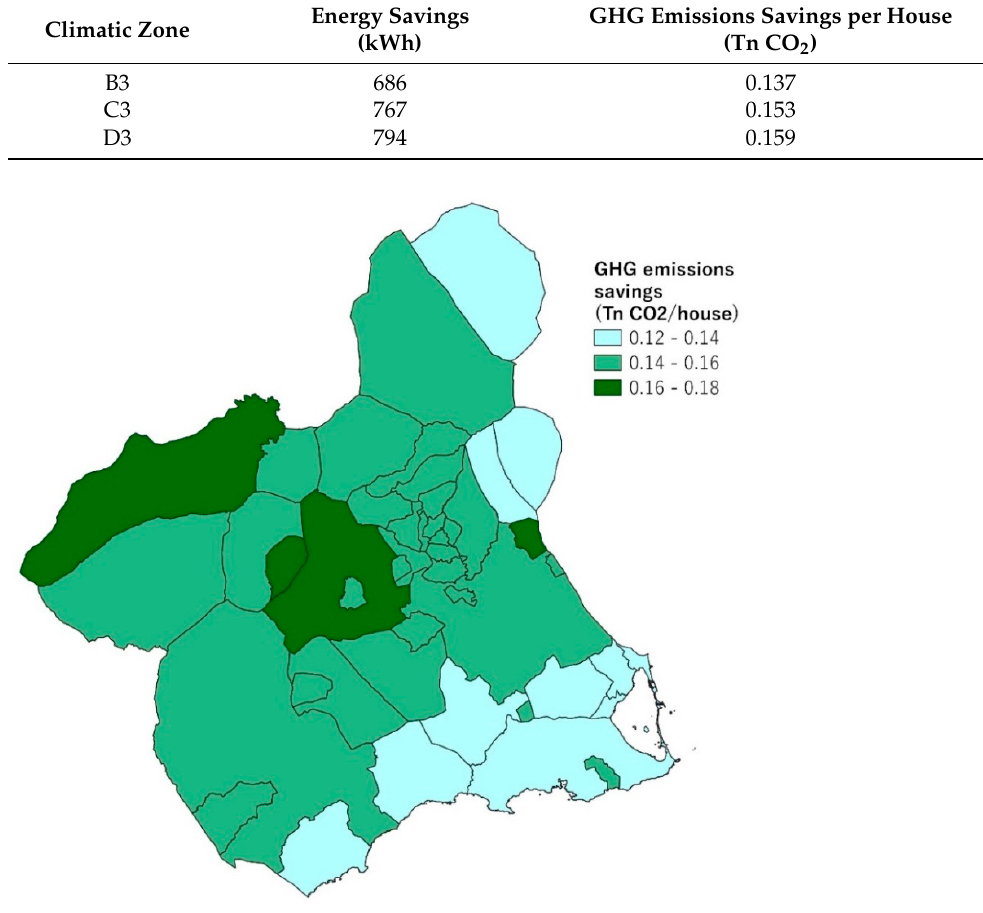
Table 3. Mean annual energy savings and GHG emissions savings per climatic zone.